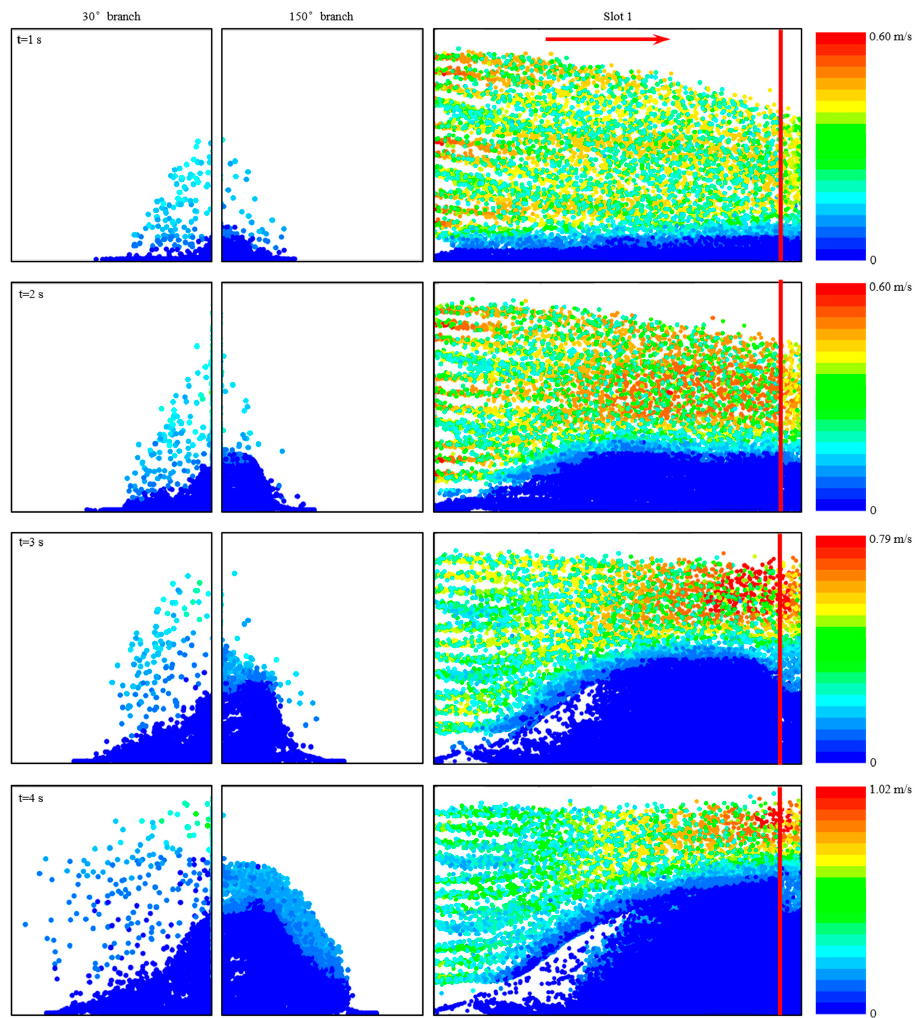
◦ - and 150 ◦ -branches. Figure 14. Mechanism of proppant transport into the 30°- and 150°-branches. Figure 14. Mechanism of proppant transport into the 30 Figure 11 indicates that a suspended layer and a rolling layer occurred on the dune top in slot